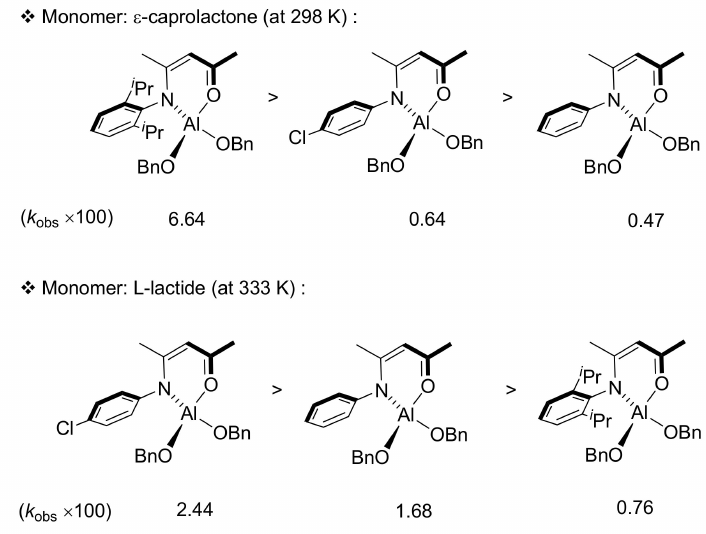
Figure 2. Experimental data summary for the ring-opening polymerization of ε -caprolactone and L -lactide initiated by aluminum ketiminate